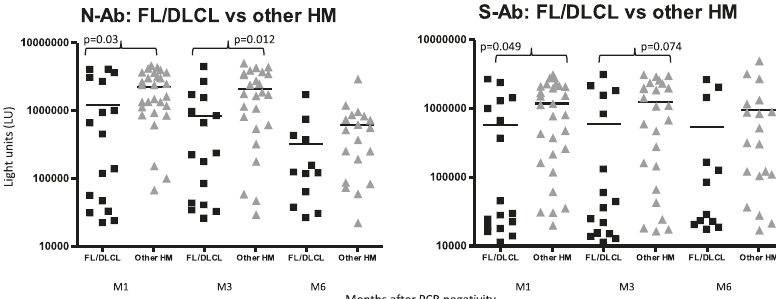
Fig. 2 Antibody levels against SARS-CoV-2 nucleocapsid and spike protein in hematologic patients with COVID-19. Antibody levels against SARS-CoV-2 nucleocapsid (NAb) and spike protein (S-Ab) were determined among the follicular lymphoma (FL) and diffuse large B-cell lymphoma (DLCL) compared with patients with other hematological malignancies. Each symbol represents an individual patient sample from 1 (M1), 3 (M3), and 6 (M6) months after nasal swabs became PCR-negative. Antibody levels are plotted in light units (LU) on the y axis and the solid horizontal line represents the mean level for each group. Statistically signi fi cant differences in antibody levels among the sample group were determined by a Student ’ s t test.